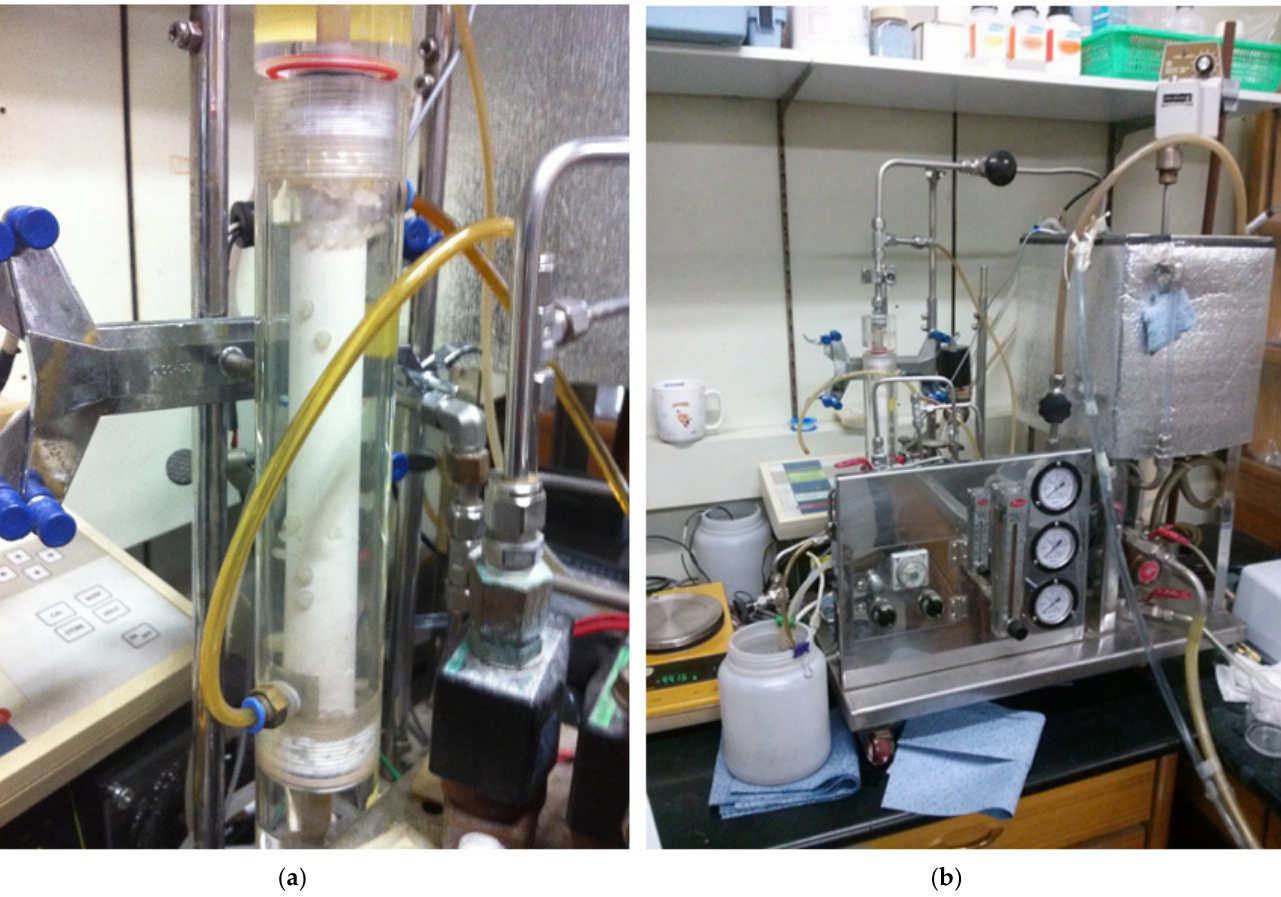
Figure 2. Combined water treatment process of tubular or seven channel MF membrane and PP beads with periodic water backwashing: ( a ) seven channel MF membrane; ( b ) total combined sys- tem.